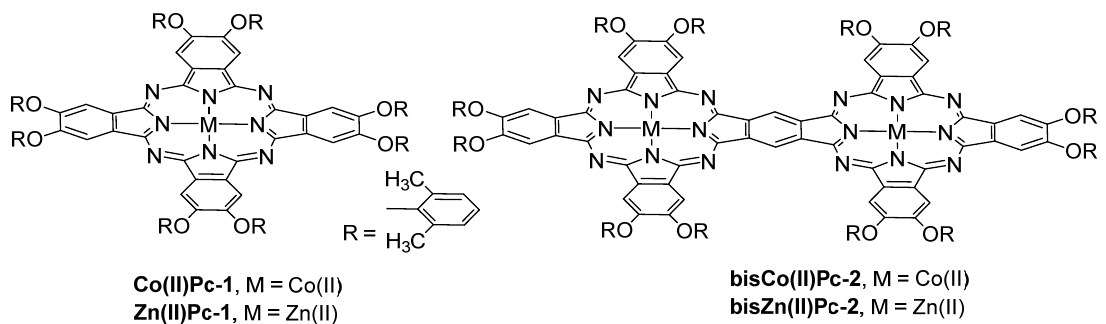
Figure 20. Structures of mononuclear Co(II) and Zn(II) phthalocyanines ( M(II)Pc-1 ) and binuclear Co(II) and Zn(II) phthalocyanines ( bisM(II)Pc-2 (adapted from [68]).